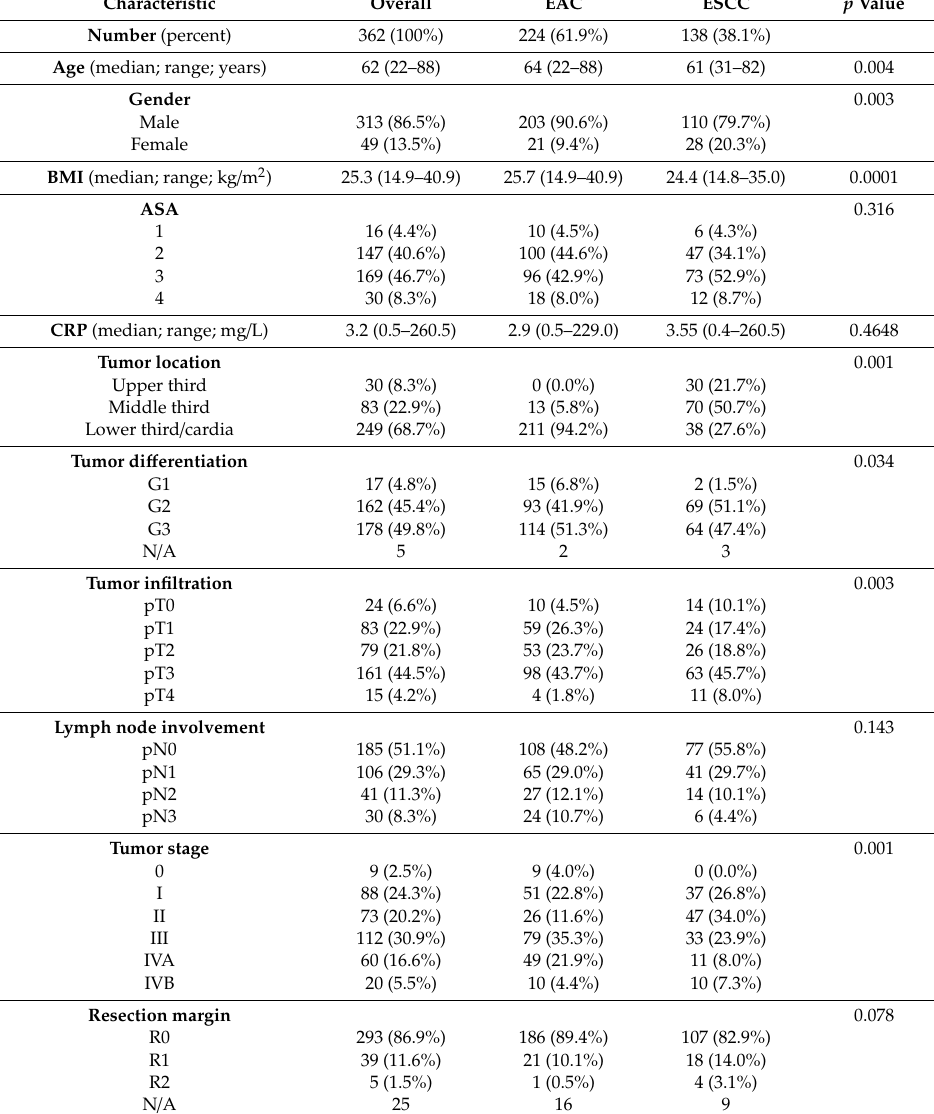
Table 1. Characteristics of 362 patients with resected esophageal cancer. Relationship